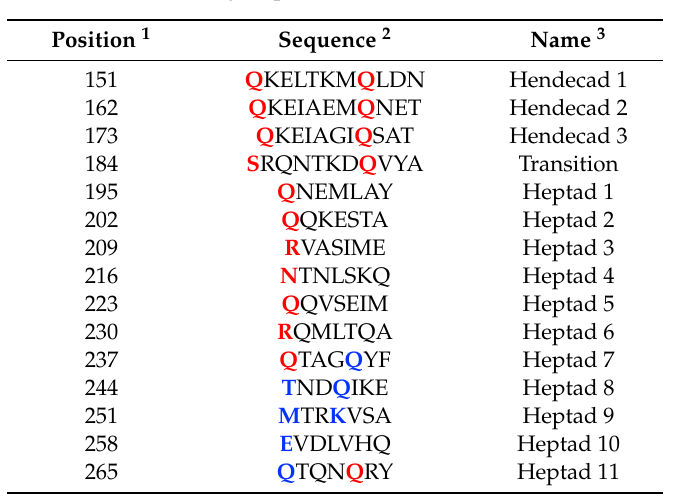
Figure 1. H-tube Structure. ( A ) The φ X174 H protein’s coiled-coil domain when oligomerized as a decamer. The amino terminal end is facing up and two opposing monomers are colored in cyan (PDB: 4JPP). In one monomer, the region spanning Q241to Q265 is depicted in blue. ( B ) The tube, as seen from its C-terminal opening. Inward facing residues are modeled as sticks. ( C ) The inner surface of three α -helices between Q241 and Q265. Inward facing side chains are modeled as sticks. Inward facing side chain labels appear to the left of the helices. Table 1. Primary sequence of the coiled-coil